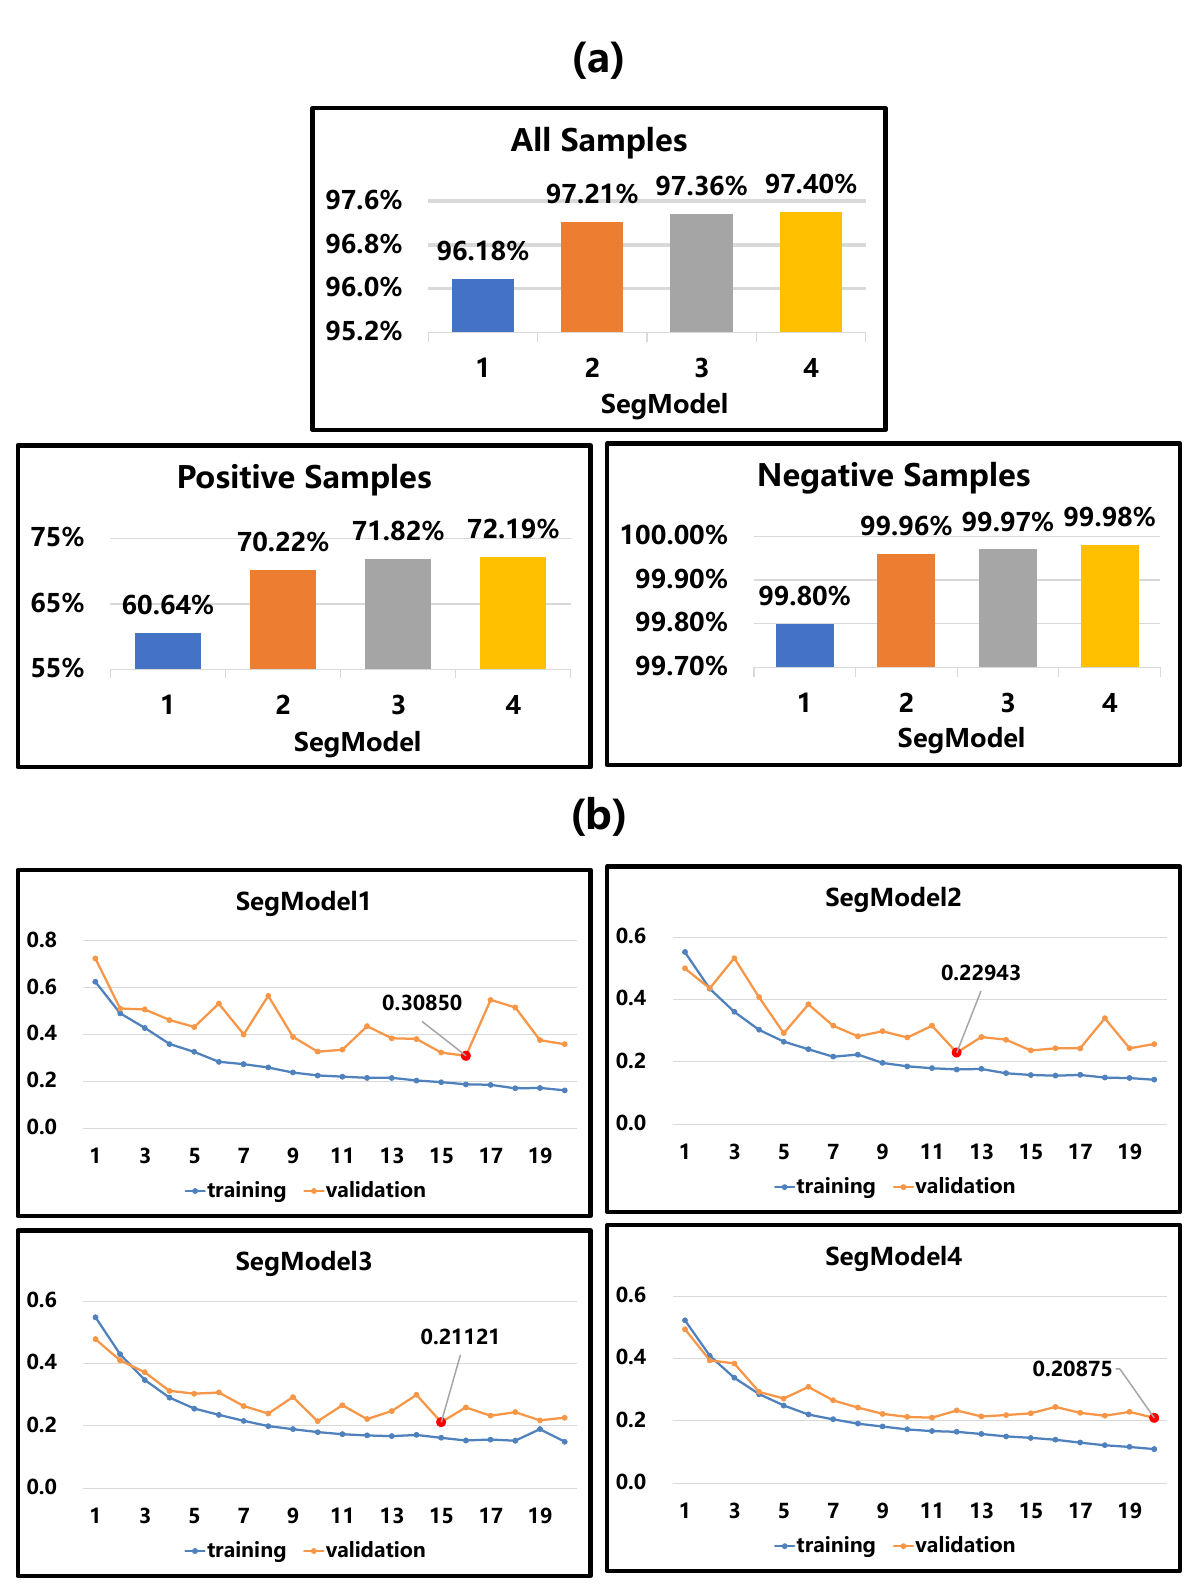
Figure 7. Comparison of four segmentation models in the training and validation process: ( a ) MIoU; ( b ) loss.